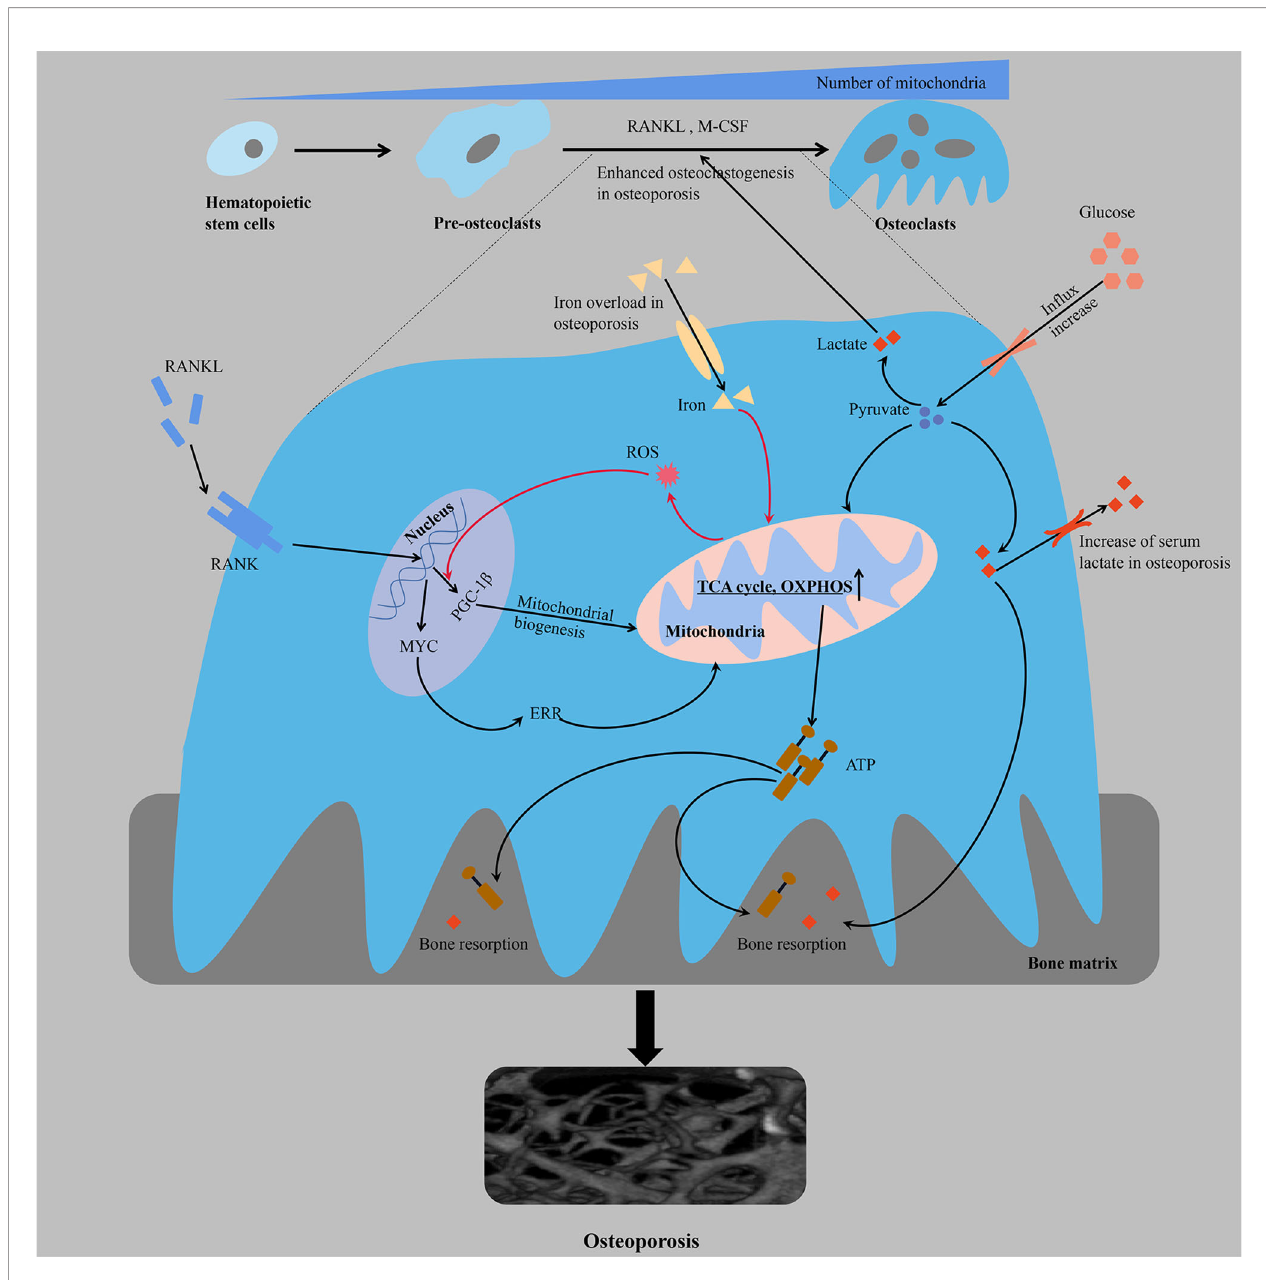
FIGURE 1 | From the perspective of energy metabolism, over-differentiation of osteoclasts leads to osteoporosis. Multifactorial regulation of osteoclastogenesis is accompanied by an increased mitochondrial number and increased cellular respiration and ATP production. The orange line represents a positive feedback mechanism. ATP, adenosine triphosphate; ERR, estrogen receptor-associated receptors; M-CSF, macrophage colony stimulating factor; OXPHOS, oxidative phosphorylation; PGC-1 b , peroxisome proliferator-activated receptor gamma coactivator-1 b ; RANK, receptor activator of NF-kB; RANKL, receptor activator of nuclear factor kappa-B ligand; ROS, reactive oxygen species; TCA cycle, tricarboxylic acid